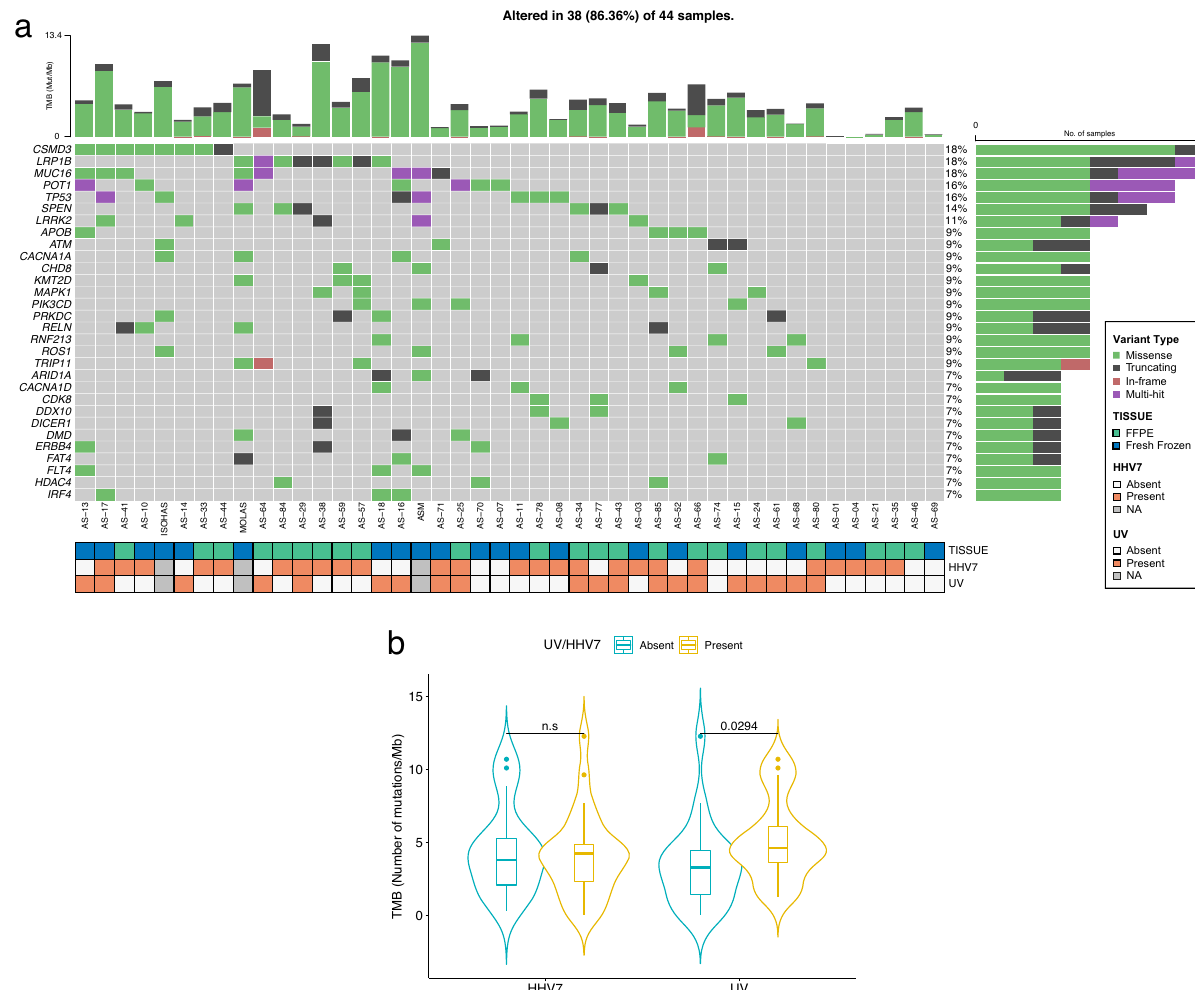
Fig. 1 Somatic mutational landscape of head and neck angiosarcoma. a Oncoplot of somatic non-synonymous variants of interest, including recurrent mutations in CSMD3 (18%), LRP1B (18%), MUC16 (18%), POT1 (16%), and TP53 (16%). The median tumor mutation burden (TMB) was 4.28 mutations per coding megabase (mt/Mb) (range, 0.03 – 13.4). b TMB was signi fi cantly higher in UV compared to non-UV-related AS-HN (median, 4.63 vs 3.30 mt/Mb, p = 0.0294 by Mann – Whitney U test). Violin plots are represented by median and lower to upper quartile values, and the vertical line extends from the minimum to the maximum value. No signi fi cant difference in TMB was observed between HHV-7-positive and HHV-7-negative